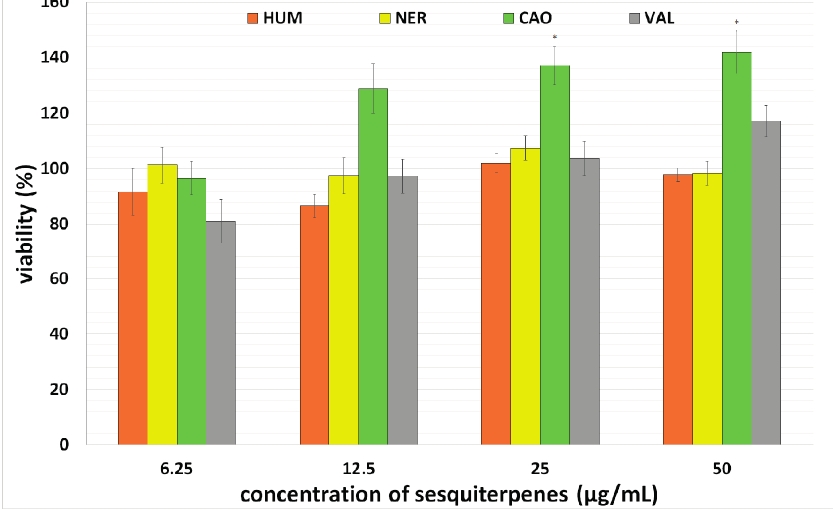
Figure 3. Effect of sesquiterpenes on viability of primary culture of rat hepatocytes assayed using a MTT test. Data presented as percentage of control cells (=100%) represent the mean ± S.D. from 2 independent experiments (with 6 parallels in each). The asterisk indicates a significant difference from the control cells ( p <